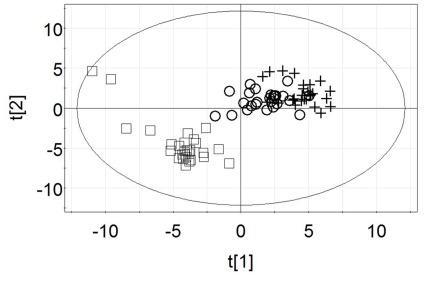
Score plots from the PLS-DA model visualize the global metabolic differences between pre-exercise (□), immediately post-exercise (+), and 1-h post-exercise (◯) for the combined data from the BAN and CHO beverage trials (75-km cycling).A satisfactory separation was obtained between time points groups (Q2Y = 0.766).